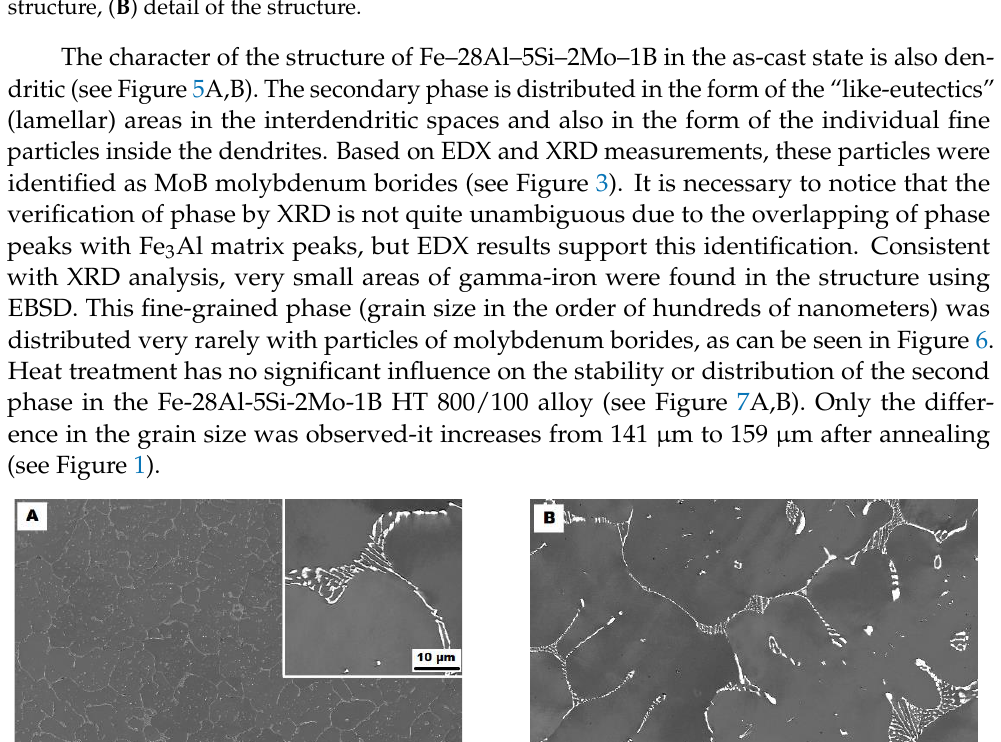
Figure 4. The structure of Fe – 28Al – 5Si – 1B HT 800/100 alloy (SEM, 10 kV, BSE). ( A) overview of the structure, ( B ) detail of the structure structure, ( B ) detail of the structure.